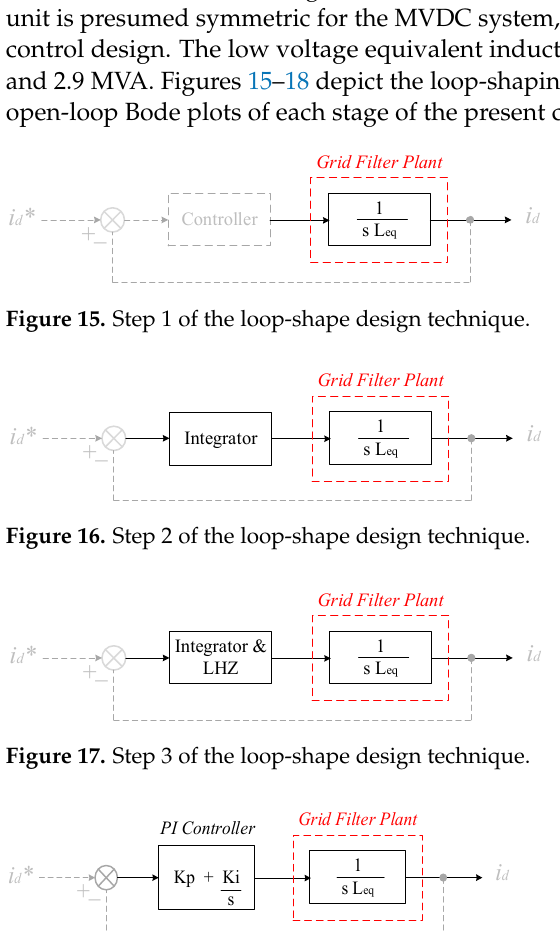
Figure 18. Step 4 of the loop-shape design technique.